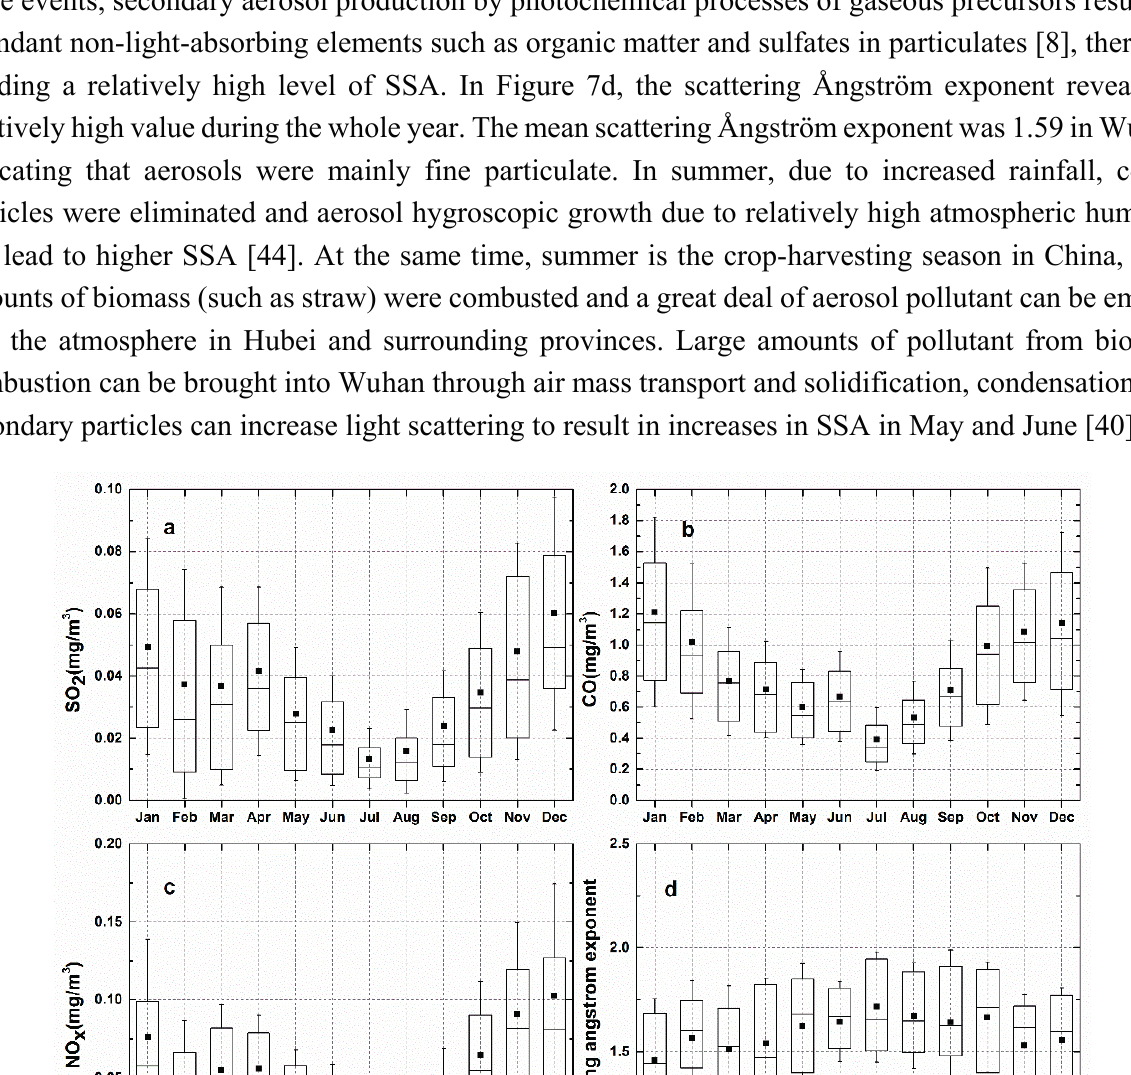
Figure 8 exhibited diurnal curves of σ two peaks at 7:00 LZT and 1:00 LZT; those of σ of σ were at 7:00 LZT (140 Mm − 1 ) and 21:00 LZT (151 Mm − 1 ), respectively. In Shanghai city, also (cid:2911)(cid:2912) an urban site, the diurnal variations in σ